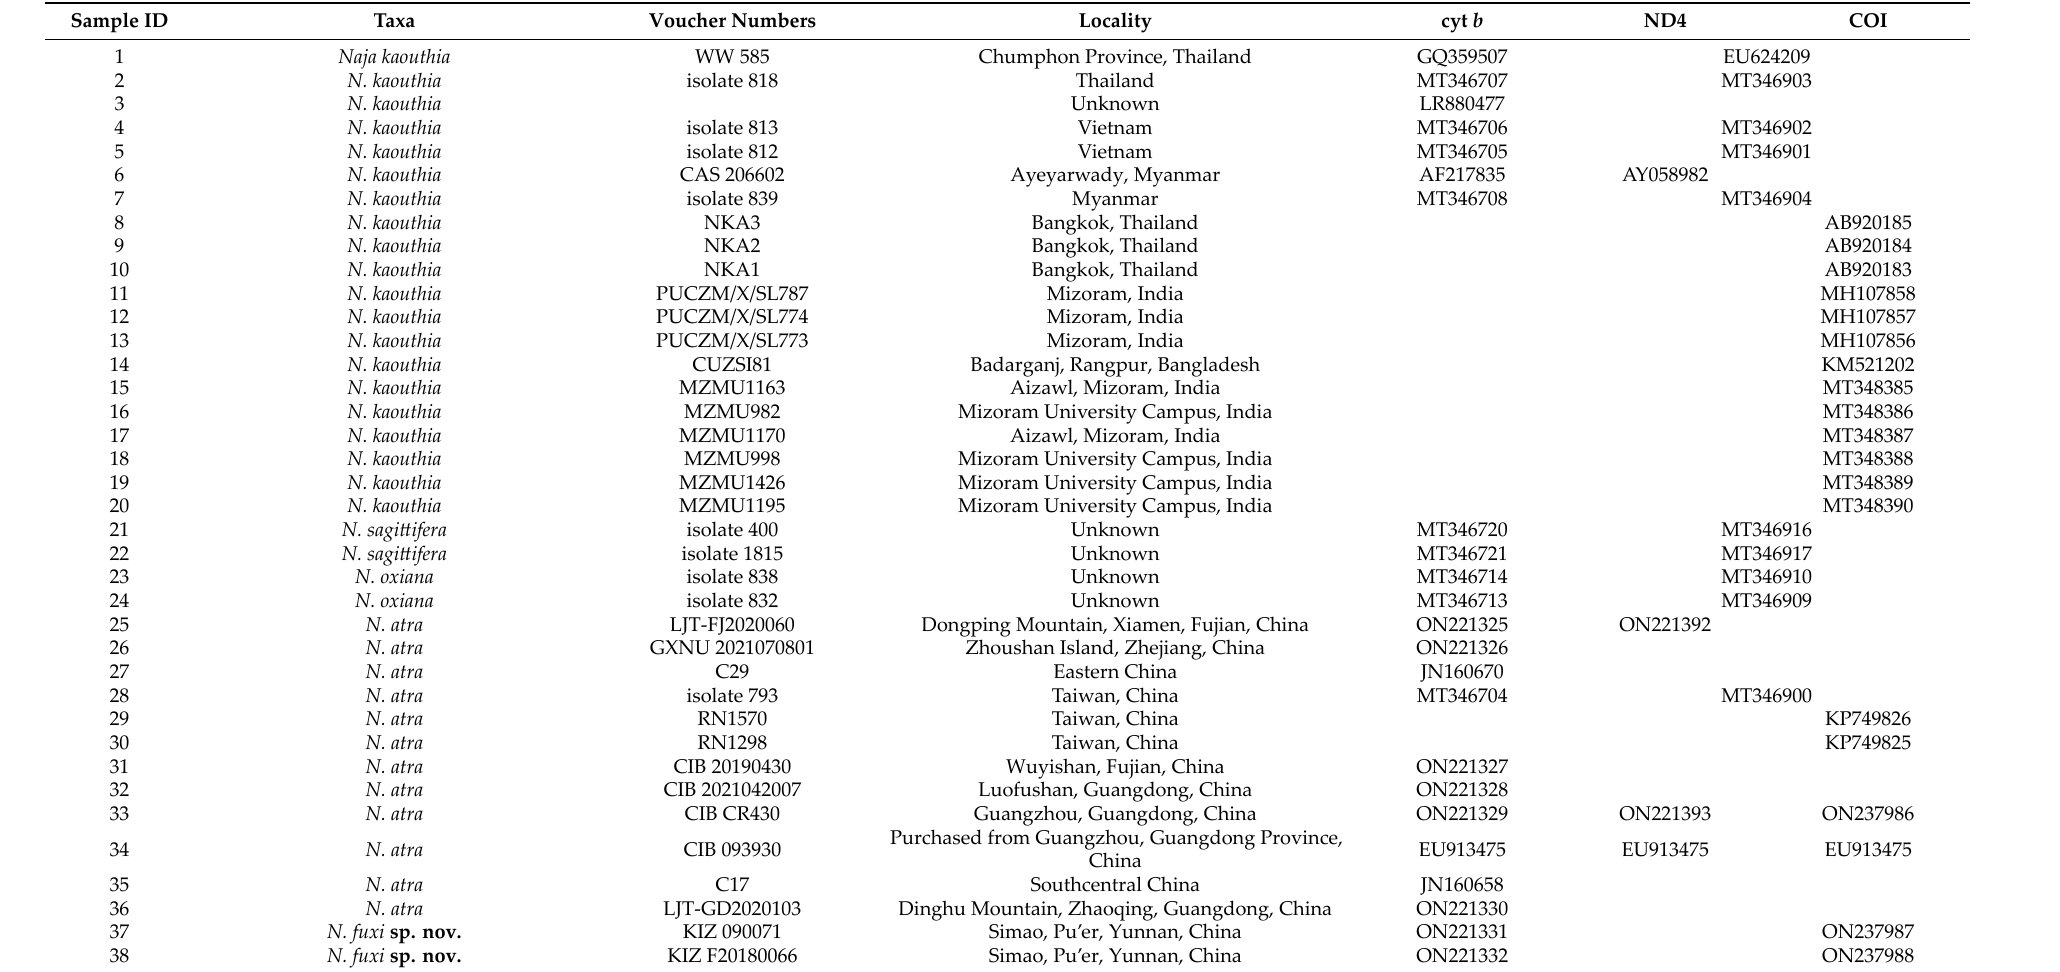
Table 1. Samples analyzed in this